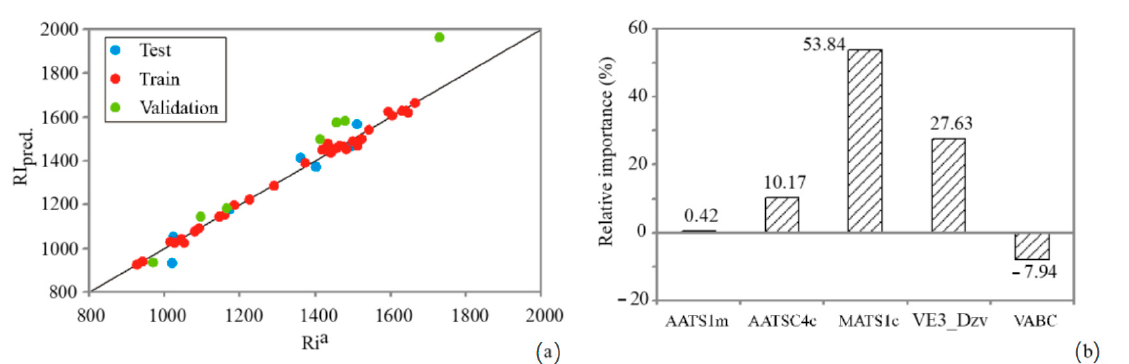
Figure 1. Retention indices of H. italicum EO composition from: experimentally obtained GC-MS data (RI a ) and predicted by the ANN (RI pred .); ( a ) the relative importance of the molecular descriptors on RI, determined using Yoon interpreta- tion method ( b ). Table 4. In vitro antibacterial ( µ L/mL), antioxidant ( µ moLTrolox equivalents (TE)/100 g), α